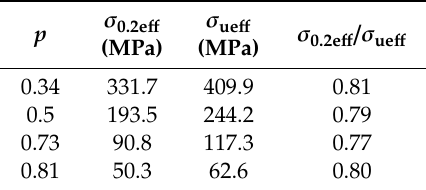
Table 4. Averaged values of the e ff ective yield strength to tensile strength of Ti6Al4V titanium alloy samples of di ff erent porosity, obtained by LPBF method.